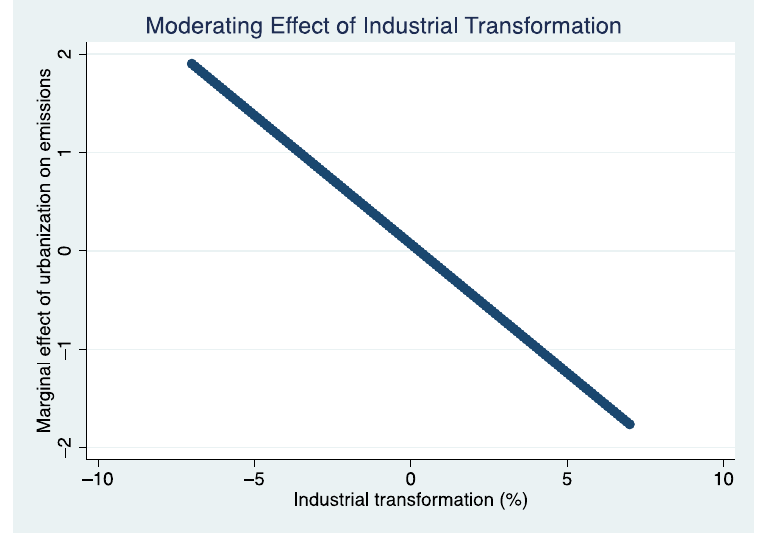
Figure 4. Moderating effect of industrial transformation.